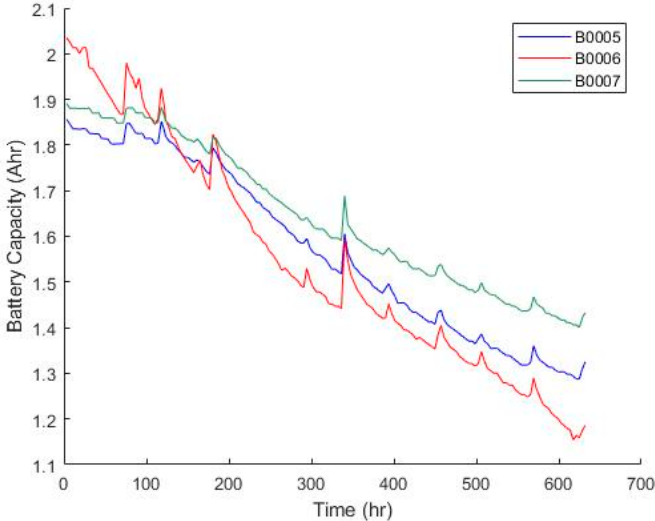
Figure 4. Capacity of Li-ion batteries.